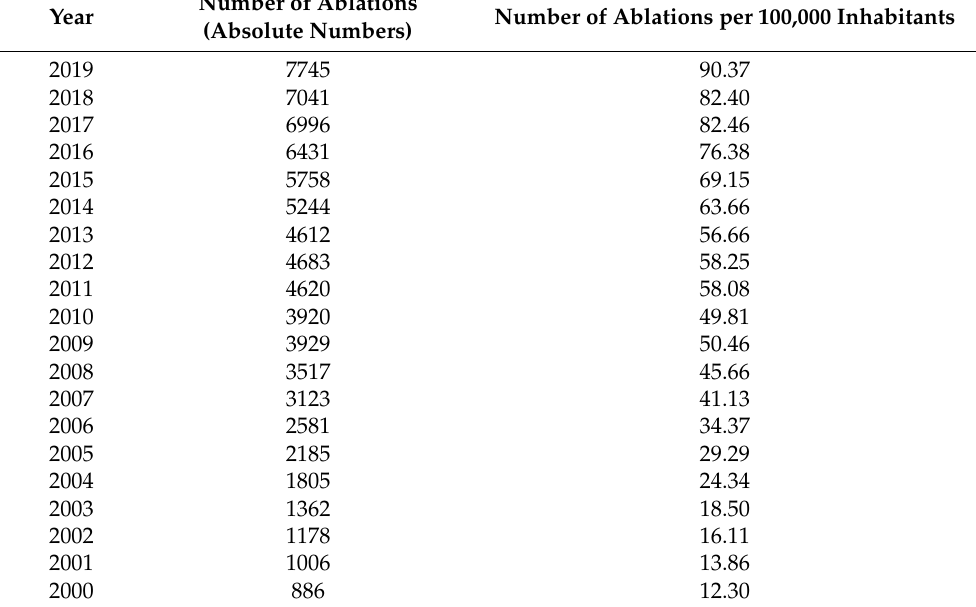
Table 1. Relative ablation numbers to the yearly population of Switzerland